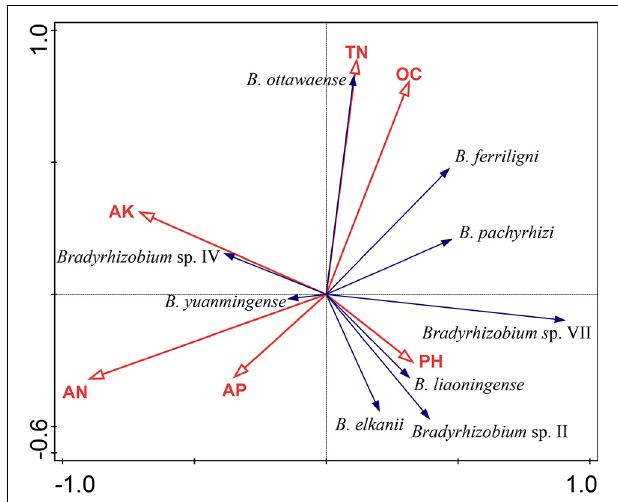
FIGURE 5 | Corresponding analyses between the genospecies and the soil physiochemical characteristics calculated by CANOCO. Genospecies accounting more than 1% was selected to perform the calculation. AN, available N; AP, available P; AK, available K; OC, organic carbon; TN, total